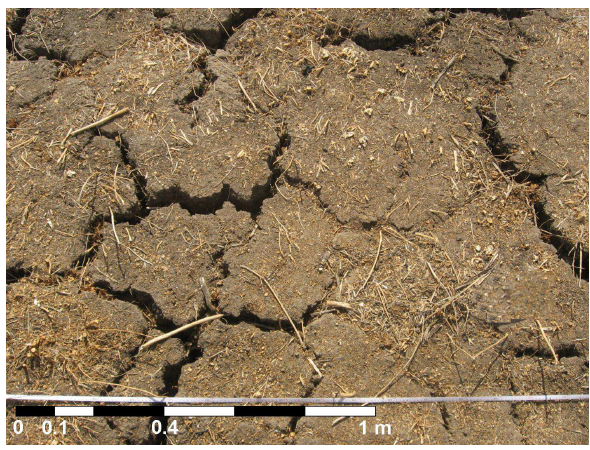
Fig. 3. Schematic side-view illustration of the vadose-zone monitoring system (VMS) installed under the waste storage pond, waste channel and the waste channel margins (a) , and front view (A-A) of the VMS installed under the channel and its margins (b) (modified from Baram et al., (2012a)).